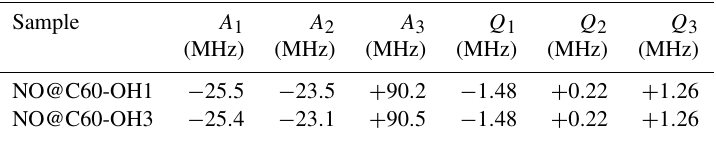
Table 3. Hyperfine parameters calculated for NO@C60-OH1 and NO@C60-OH3 in their “up” configuration using Gaussian G16/A03 (G16/A03, B3LYP, 6-311++). The calculated values for the “down” orientation differ by less than 3%.